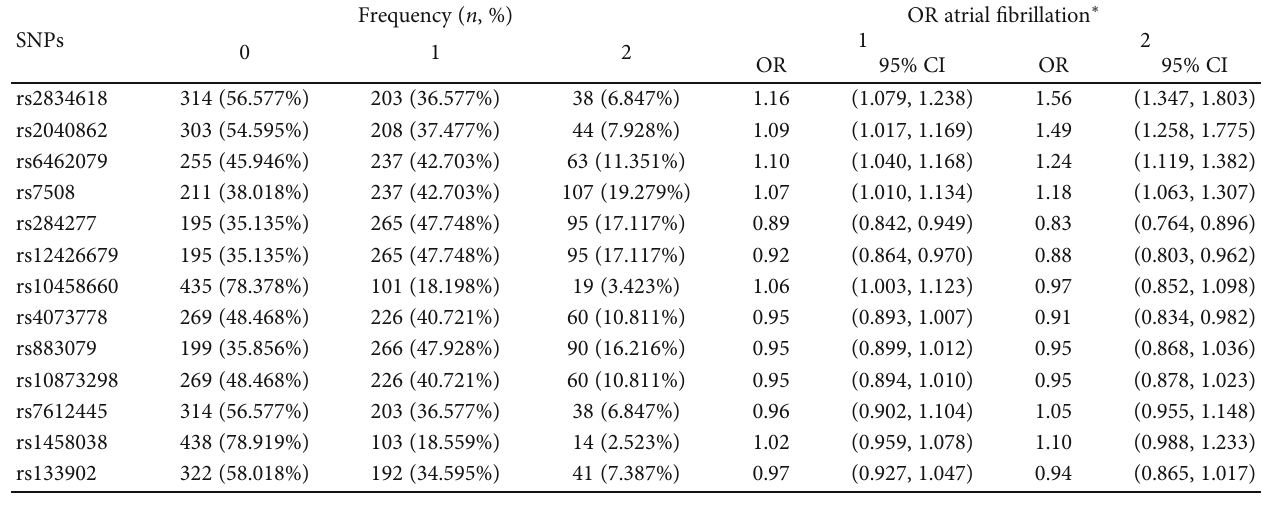
Figure 1: Density plots for the European, Native American, and African ancestry percentage. Table 3: Linear regression analysis of the association between each relevant SNPs and AF in Puerto Rican Hispanics. SNPs were chosen from previous reports that showed a signi fi cant association with AF in Europeans.